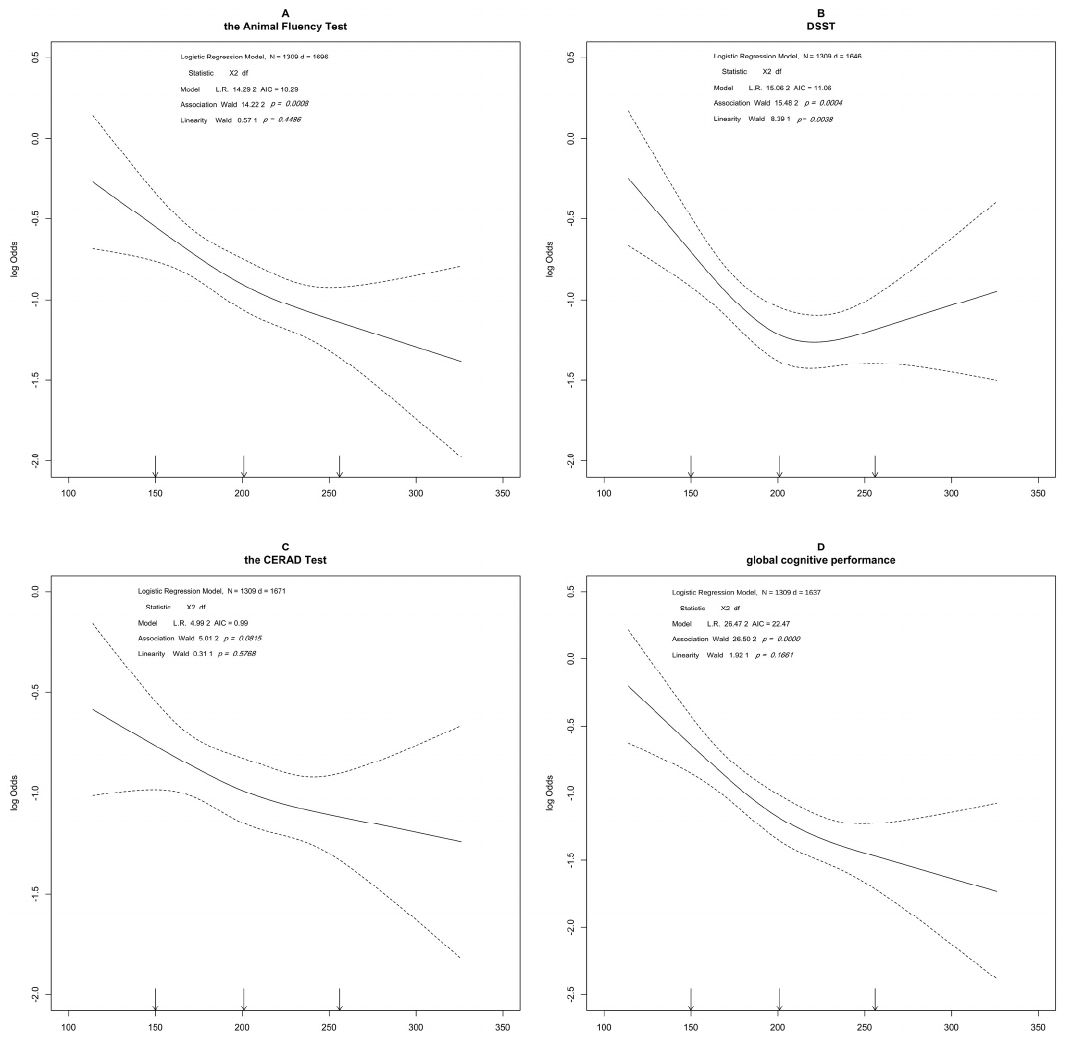
Figure 2. Restricted cubic spline analyses for female participants. Restricted cubic spline analyses between total cholesterol and the Animal Fluency Test score ( A ), the DDST ( B ), the CERAD test ( C ) and the global cognitive performance ( D ). The solid line and dashed line represent the estimated ORs and their 95% confidence intervals (OR, odds